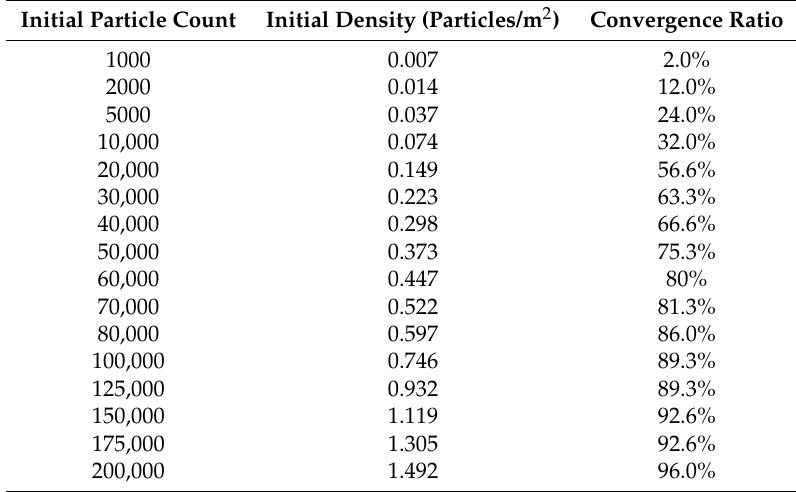
Table 2. Statistical results for the relocalization benchmark with an initial uncertainty area of the entire campus. Refer to Section